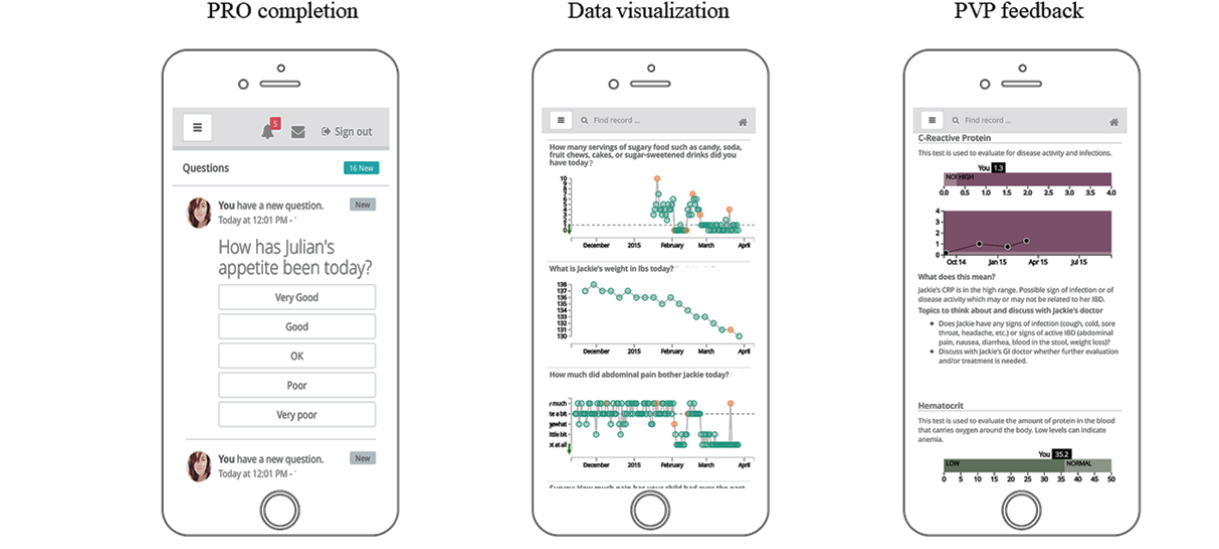
Figure 1. “Orchestra” participant mobile app example screens. PRO: patient-reported outcome; PVP: previsit